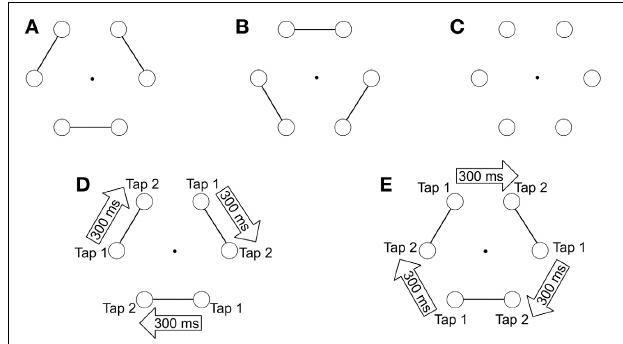
FIGURE 1 | (A,B) present the two images used to test the influence of visual grouping (connecters) on motor performances. (C) was used in the neutral condition (absence of connecters). (D,E) illustrate the tapping task on image A, during which participants are required to execute pairs of taps on adjacent circles. The two taps of a pair are separated by short intervals of 300ms, whereas pairs are separated from one another by longer intervals of 600ms. In the congruent condition, pairs of taps are to be executed on connected circles (D) , whereas in the non-congruent condition, pairs of taps are directed toward unconnected circles (E)